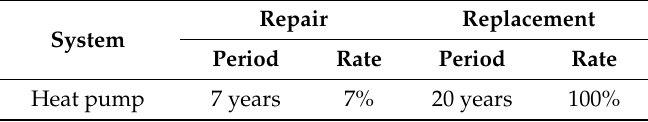
Table 7. Maintenance costs.